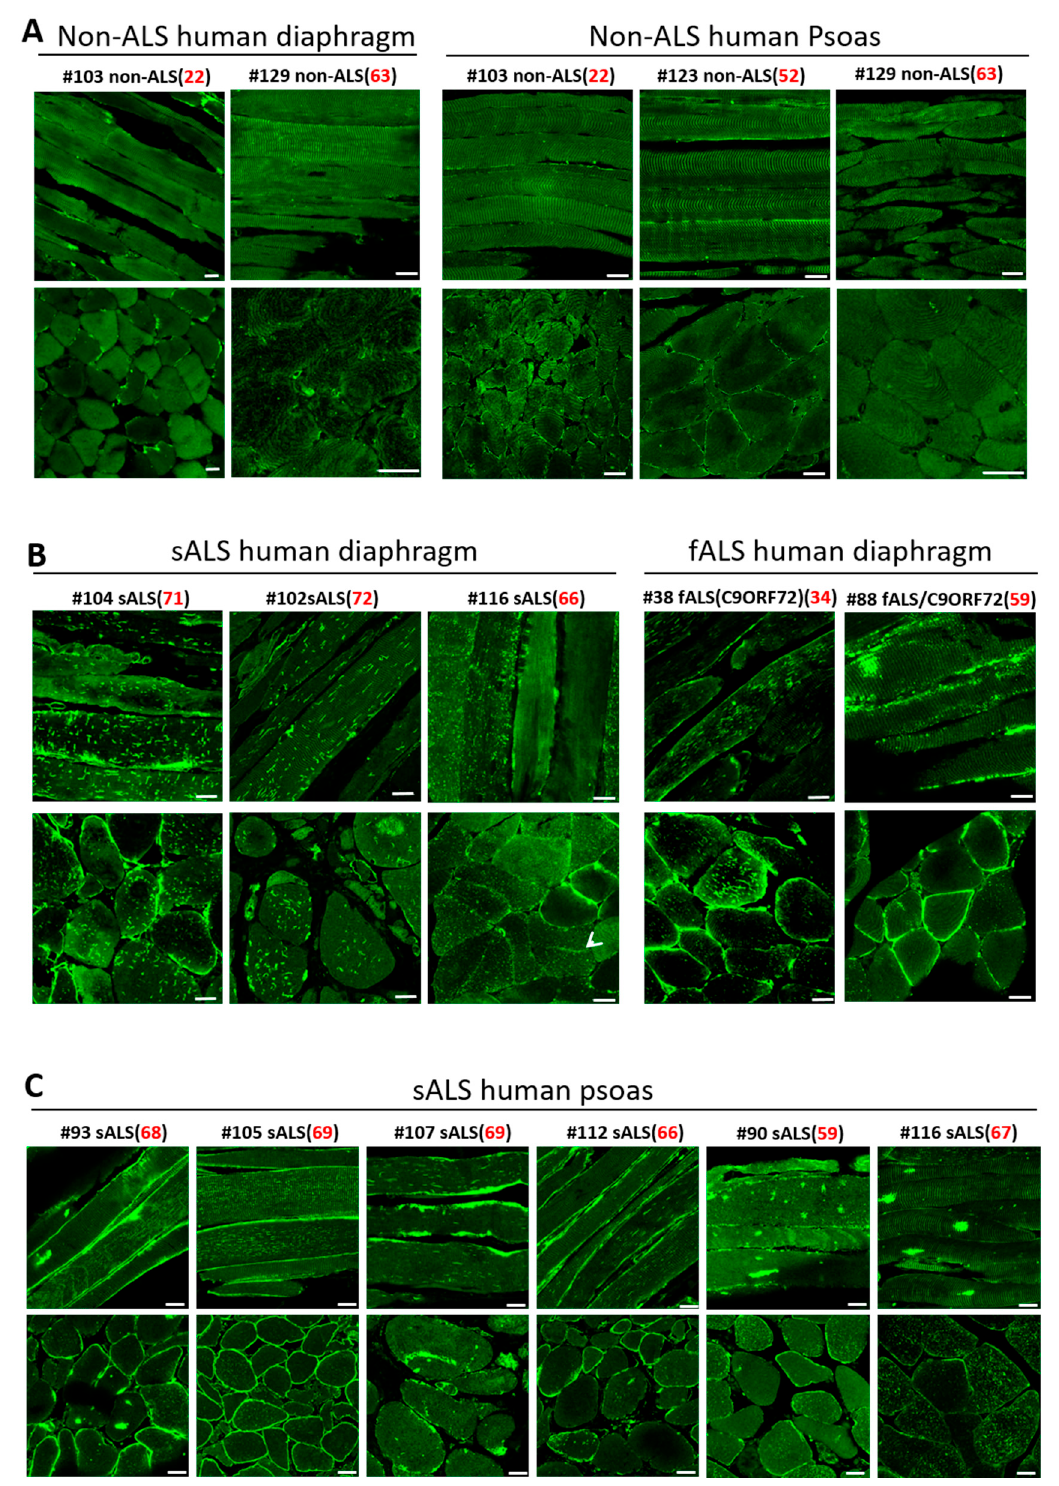
Figure 5. MG53 aggregation is a common pathological feature of skeletal muscle in both sporadic and familial human ALS. ( A ) Longitudinal (top panels) and cross-sectional (bottom panels) staining of MG53 demonstrated uniform patterns with few MG53 aggregates in non-ALS human diaphragm (left) and psoas muscle (right). ( B ) Human ALS diaphragms (sALS: sporadic ALS: fALS: familial ALS) displayed extensive intracellular aggregates of MG53. ( C ) Human ALS psoas muscles derived from both sALS and fALS displayed extensive intracellular MG53 aggregates. The age at the death is indicated in red font. Scale bars: 20 µ